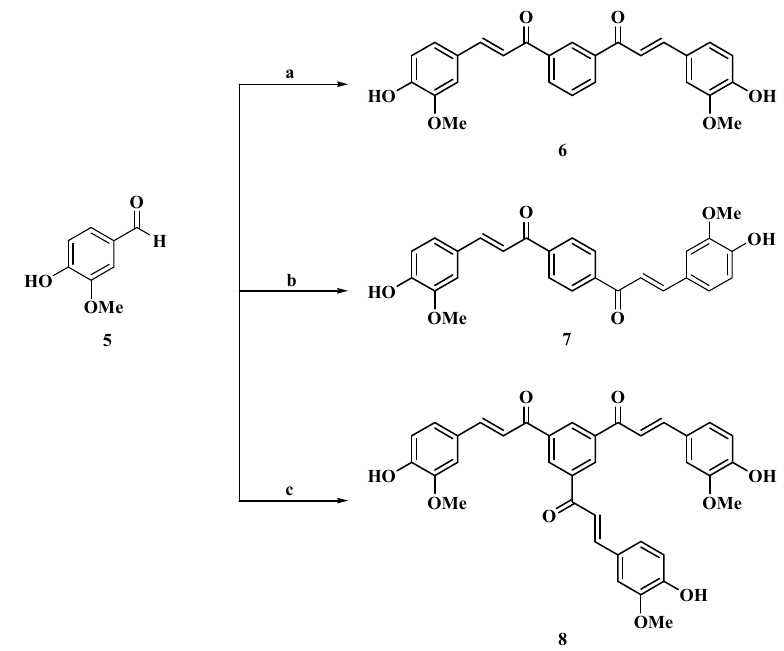
Table 1. Results of the molecular modelling study for benzylideneacetophenone derivatives.